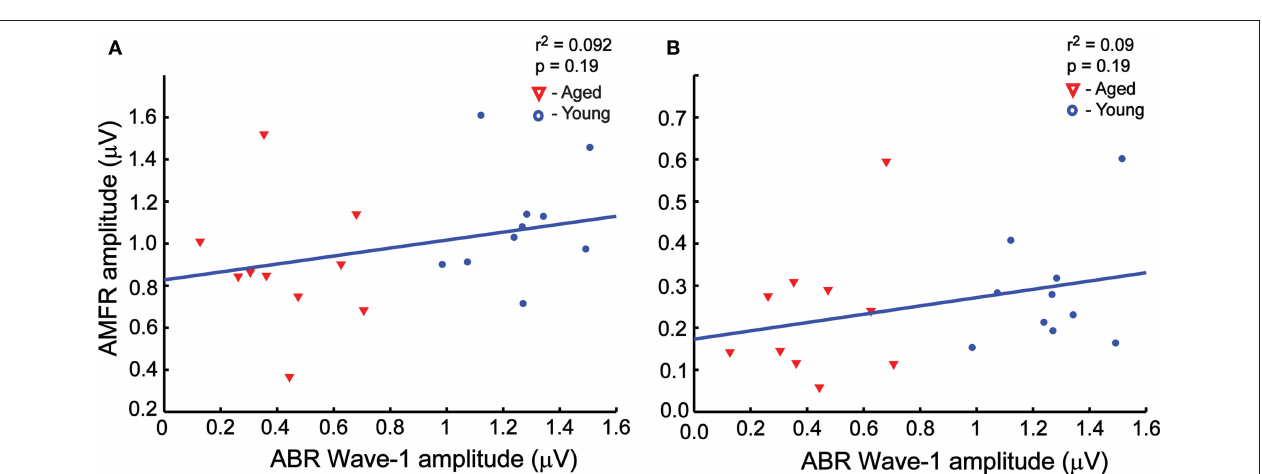
30 dB relative to threshold is plotted along the x axis, and the AMFR amplitudes for the SAM stimuli at 30 dB relative to threshold is plotted along the y axis. Similar results were observed for wave III ABR amplitudes vs. AMFR amplitudes (not shown).